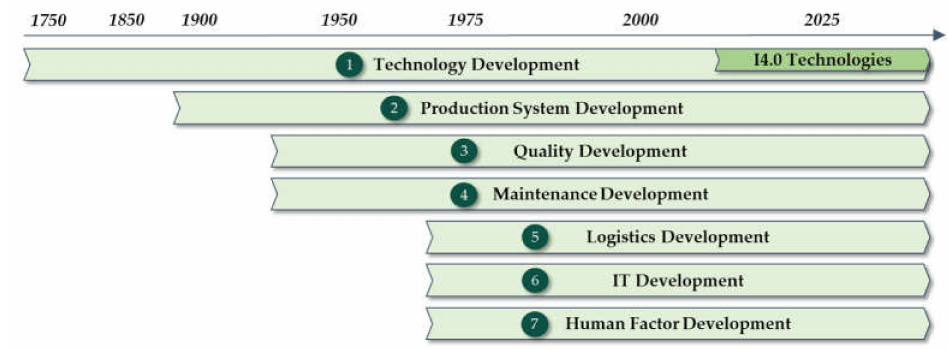
Figure 2. Functional Areas Development (the authors’ own elaboration).